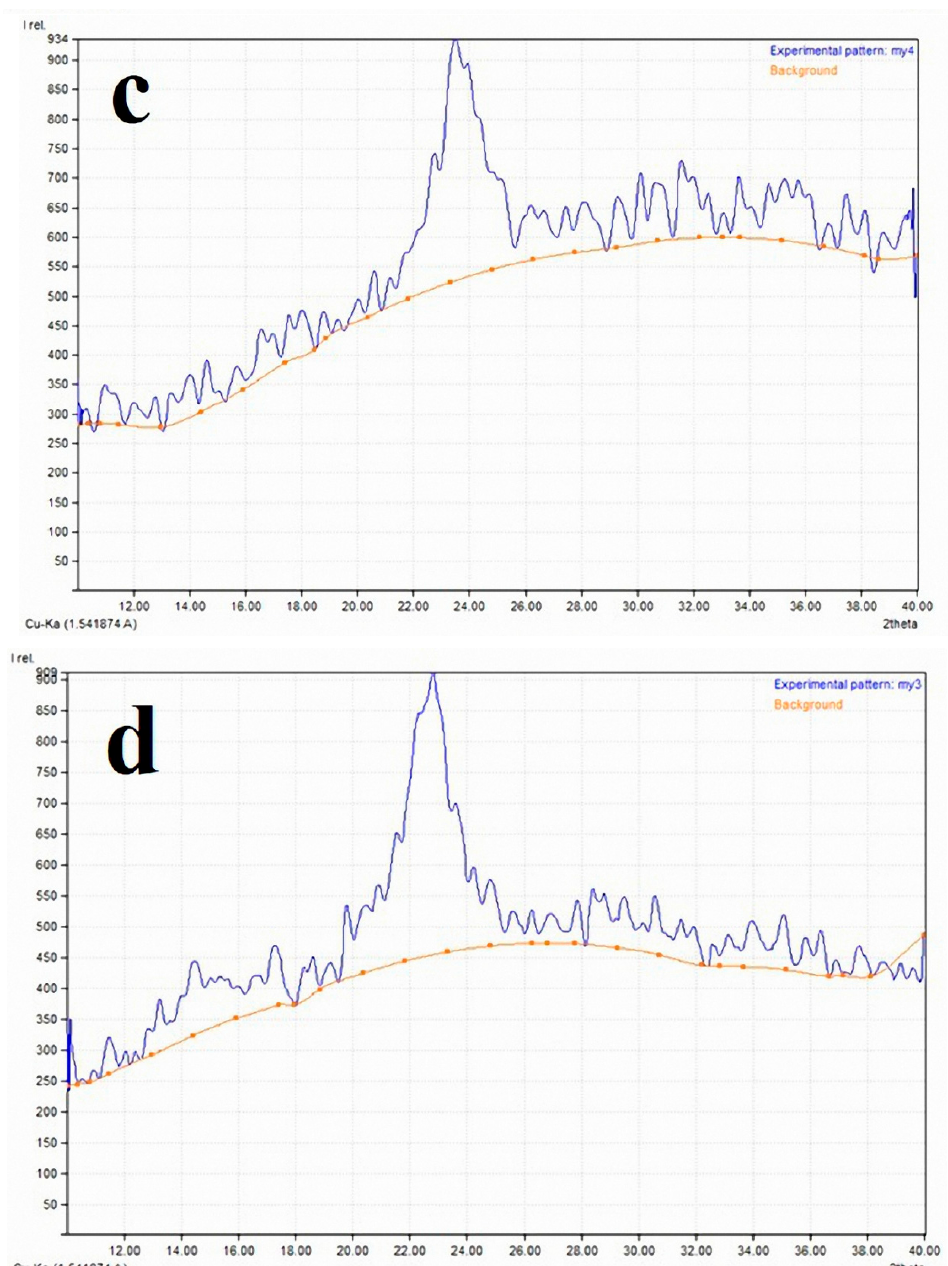
Figure 3. X-ray Diffraction Analysis (XRD) patterns for measuring the crystallinity index of the linen cellulose; ( a ) control; ( b ) linen inoculated with A. flavus ; ( c ) linen inoculated with C. cladosporioides ; ( d ) linen inoculated with P. chrysogenum .